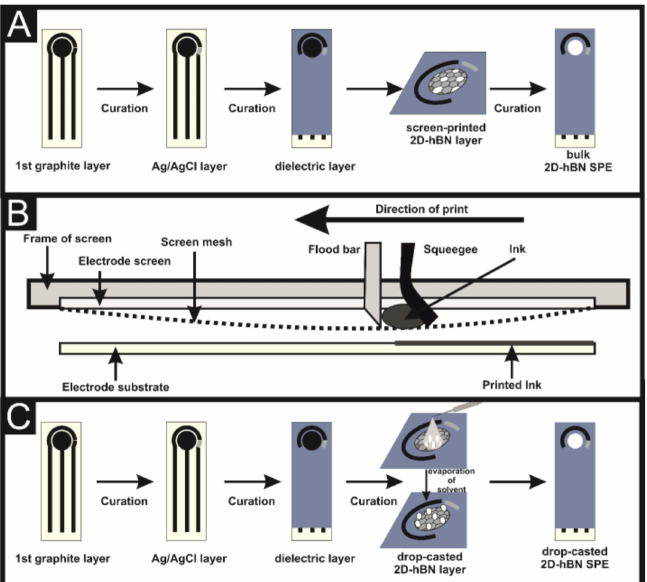
Figure 1. A schematic representation of the screen-printing process utilised to produce the bulk 2D-hBN/SPEs reported herein ( A ), a schematic cross-section of a screen-print ( B ) and a comparison with the usual drop-casting method ( C